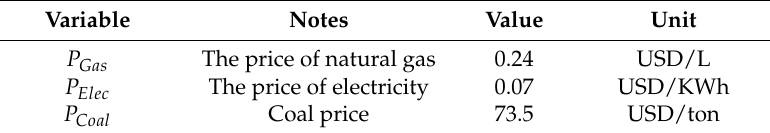
Table 7. Economic analysis data input.